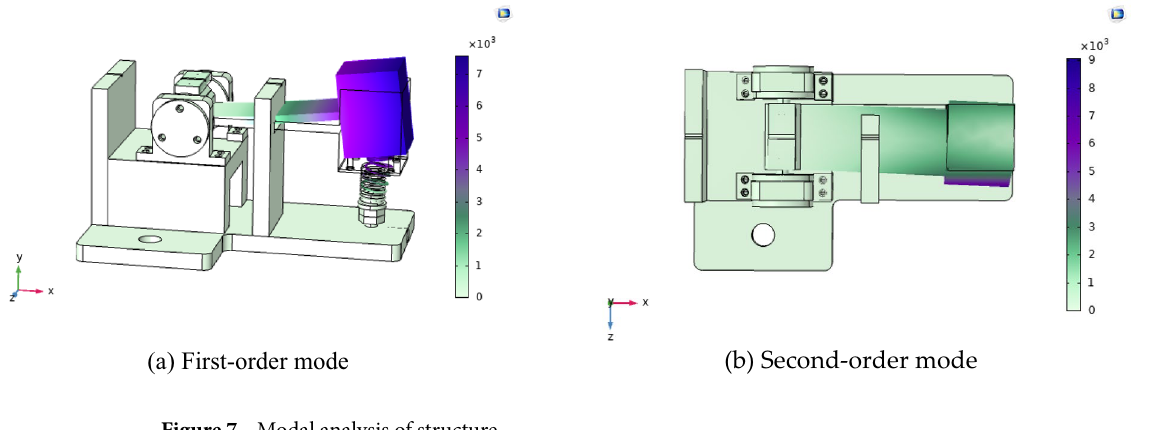
Figure 7. Modal analysis of